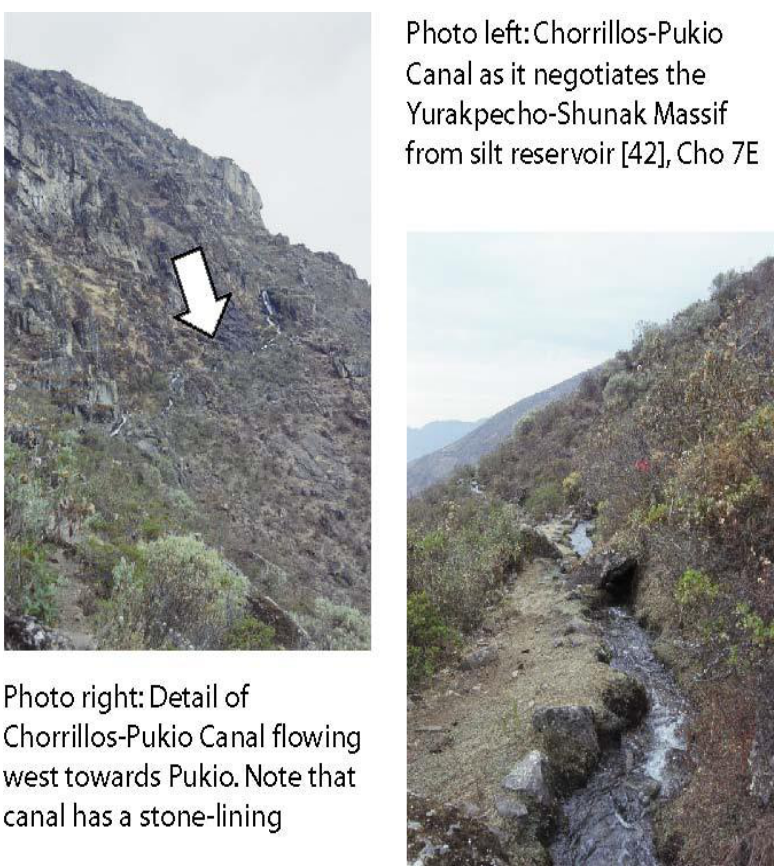
Figure 5. Stone-lined Chorrillos-Pukio canal.